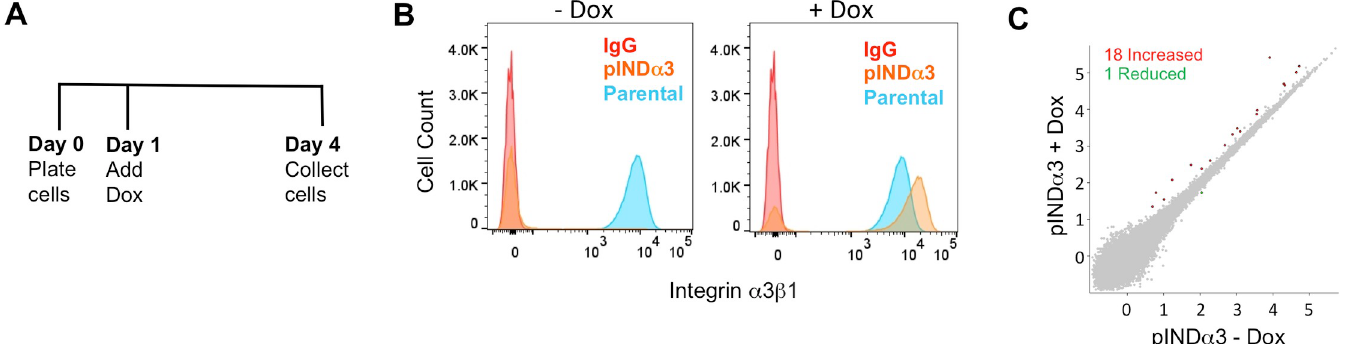
Fig 4. Restoration of α 3 β 1 to α 3-Cr cells fails to restore α 3 β 1-regulated gene expression. (A) Timeline of pIND α 3 cells treatment with doxycycline to induce α 3 β 1 expression prior to flow cytometry and RNA-seq analysis. (B) Flow cytometry with monoclonal antibody P1B5 to assess surface levels of α 3 β 1 in pIND α 3 cells (orange peaks) that were left untreated (-Dox, left graph) or were treated with doxycycline (+Dox, right graph). Parental cells were assayed with P1B5 as a positive control (shared blue peak for both graphs), or with IgG as a negative control (shared red peak for both graphs). (C) Scatterplot (relative gene expression, log 10 scale) shows pairwise comparison of RNA-seq data from pIND α 3 cells that were either untreated or treated with doxycycline. The number of genes that showed increased expression (red) or reduced expression (green) in doxycycline-treated cells (i.e., with restored α 3 β 1 expression) compared to untreated, from a total of 37,671 discovered genes, is indicated. FDR < 0.05; fold-change >